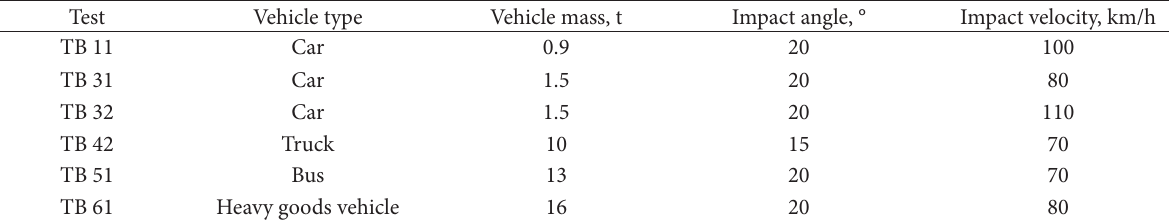
Table 1 . Different types of tests according to EN 1317